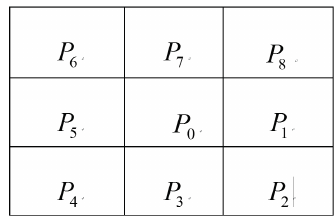
P and its eight neighboring 0